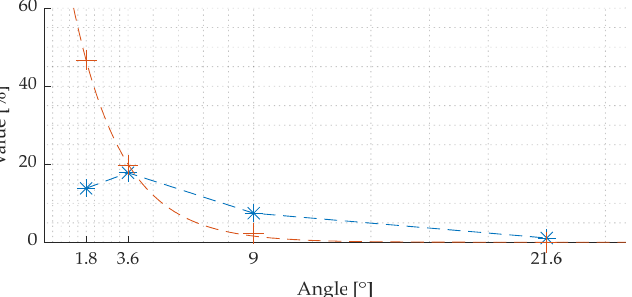
Figure 11. Percentage growth of parameter %AccTestSet (depicted with blue line) along with the deviation of it from 100% level (depicted with orange line) after applying the predictions updating algorithm.